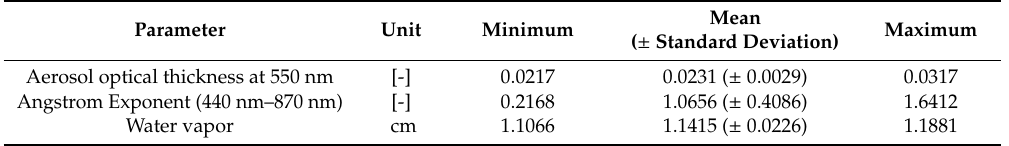
Table 1. Atmospheric parameters from Maritime Aerosol Network (AERONET) Microtops